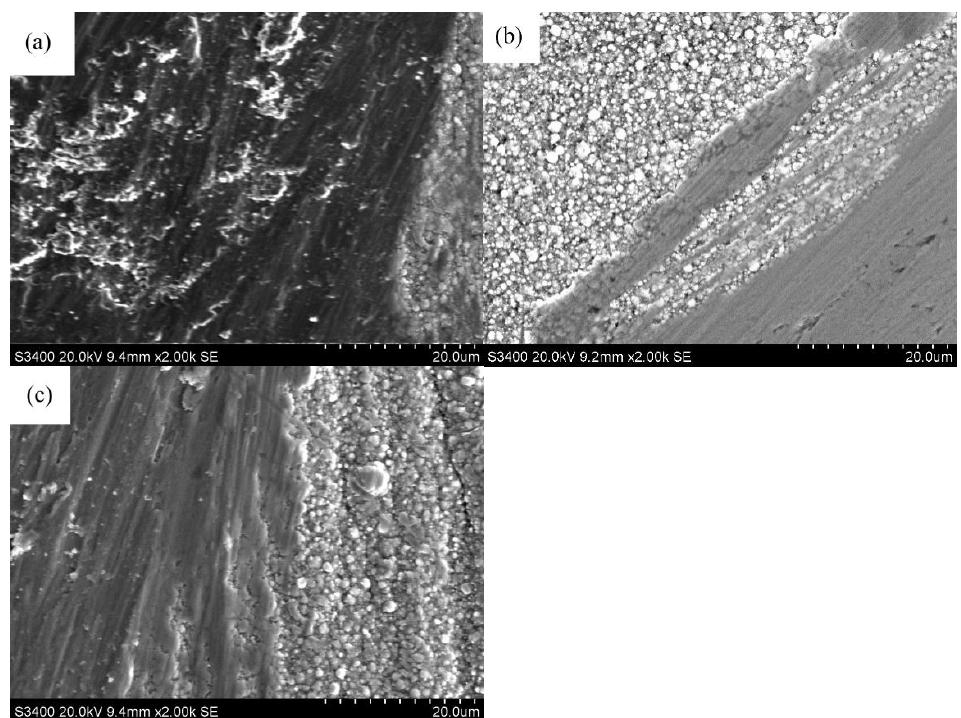
Figure 9. Micrographs of SEM for the worn surfaces of Ni/TiN-SiC nanocomposites generated using various pulse current densities: ( a ) 2 A/dm 2 , ( b ) 4 A/dm 2 , and ( c ) 6 A/dm 2 .